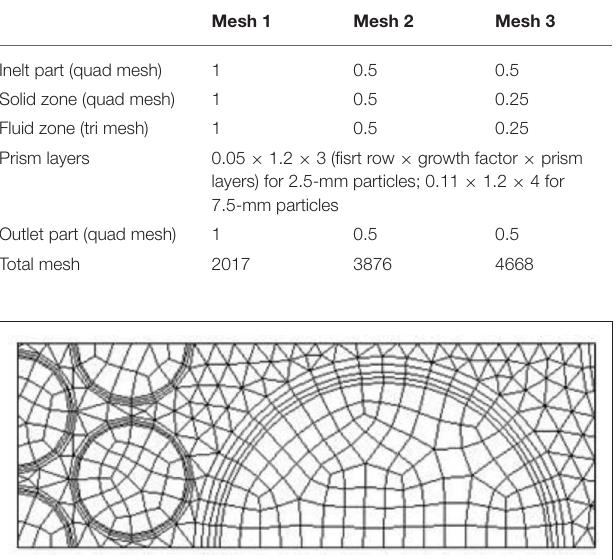
as polynomial functions of the temperature (Munro, 2010). The density of pellets is specified as 3,984 kg/m 3 . The absorption coefficient and emissivity of the pellets are set to be 80 m − 1 and 0.4 (Henneke and Ellzey, 1999).